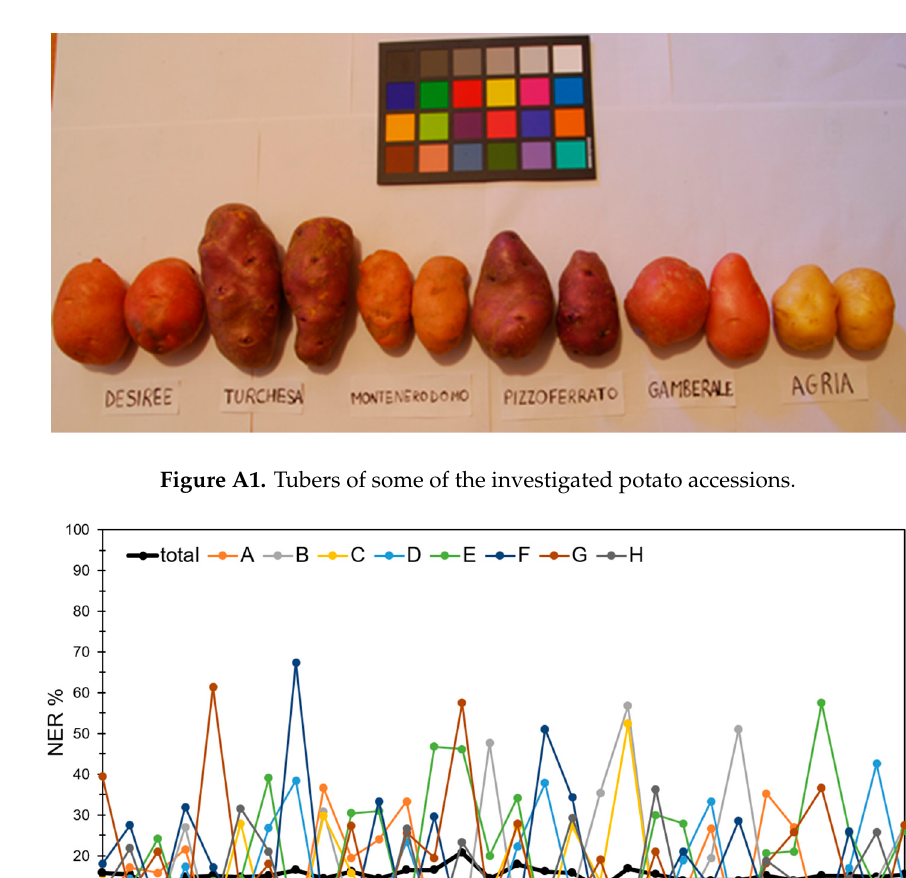
Figure A2. Proportion (%) of correctly classified potato samples using PLS-DA in cross-validation.